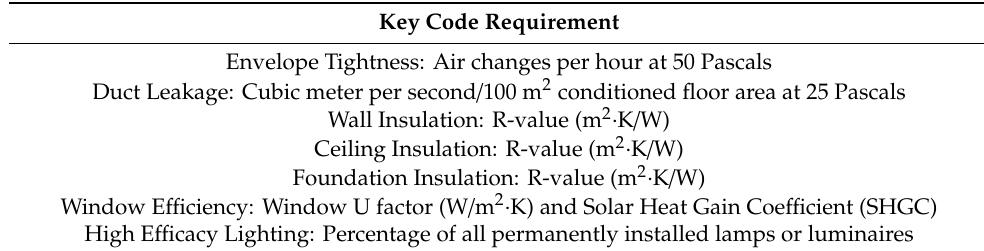
Table 1. Key Code Items Identified in the Sensitivity Analysis. Key Code